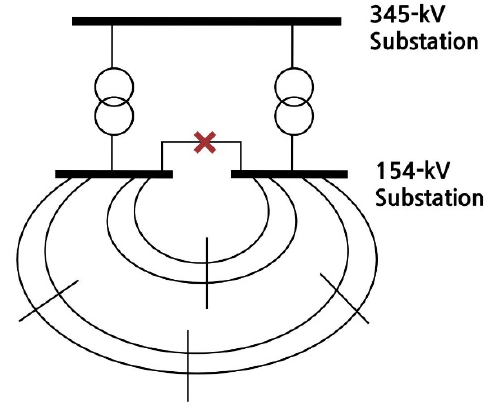
Figure 2. Busbar separation method with an insufficient transformer capacity.